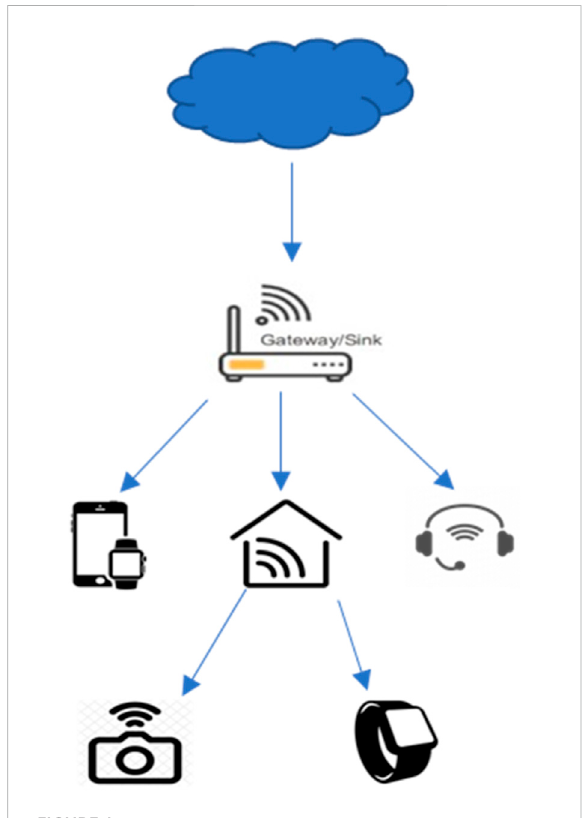
FIGURE 1 A simple hierarchical model for an IoT